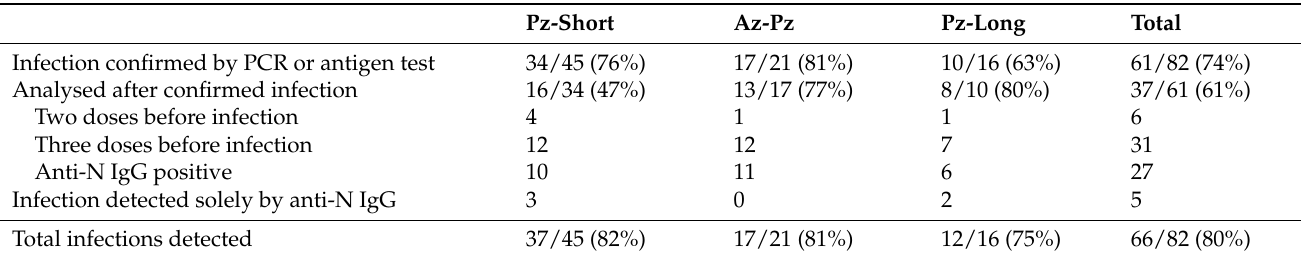
Table 3. Detection of SARS-CoV-2 infection. Data are